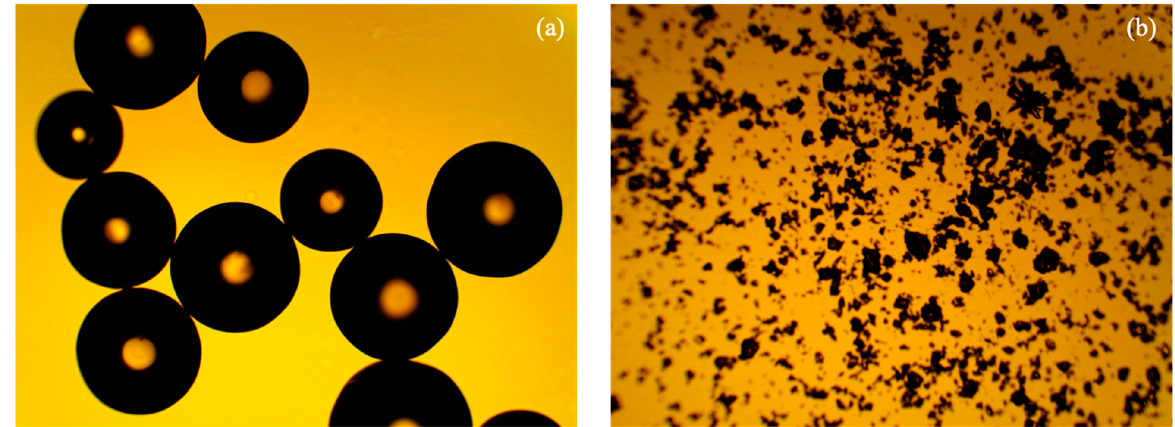
important to note that all the current efficiency values were statistically the same ( p > 0.4). Figure 9. Optical microscopy images of ( a ) unground IR 120 Na + resin and ( b ) ground IR 120 Na + resin.